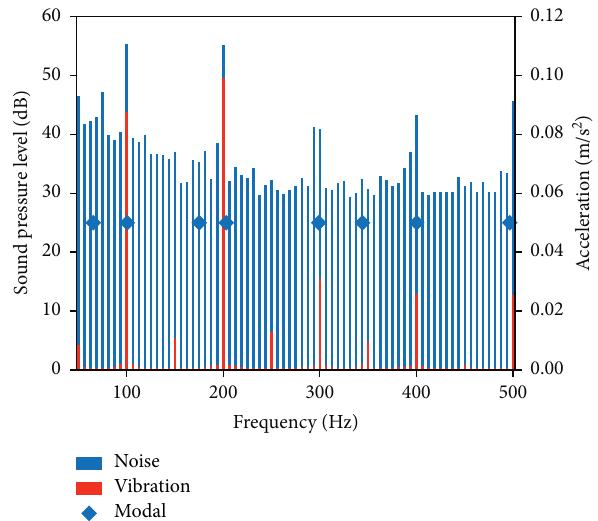
Figure 22: Correlation analysis of vibration, noise, and modal points of core